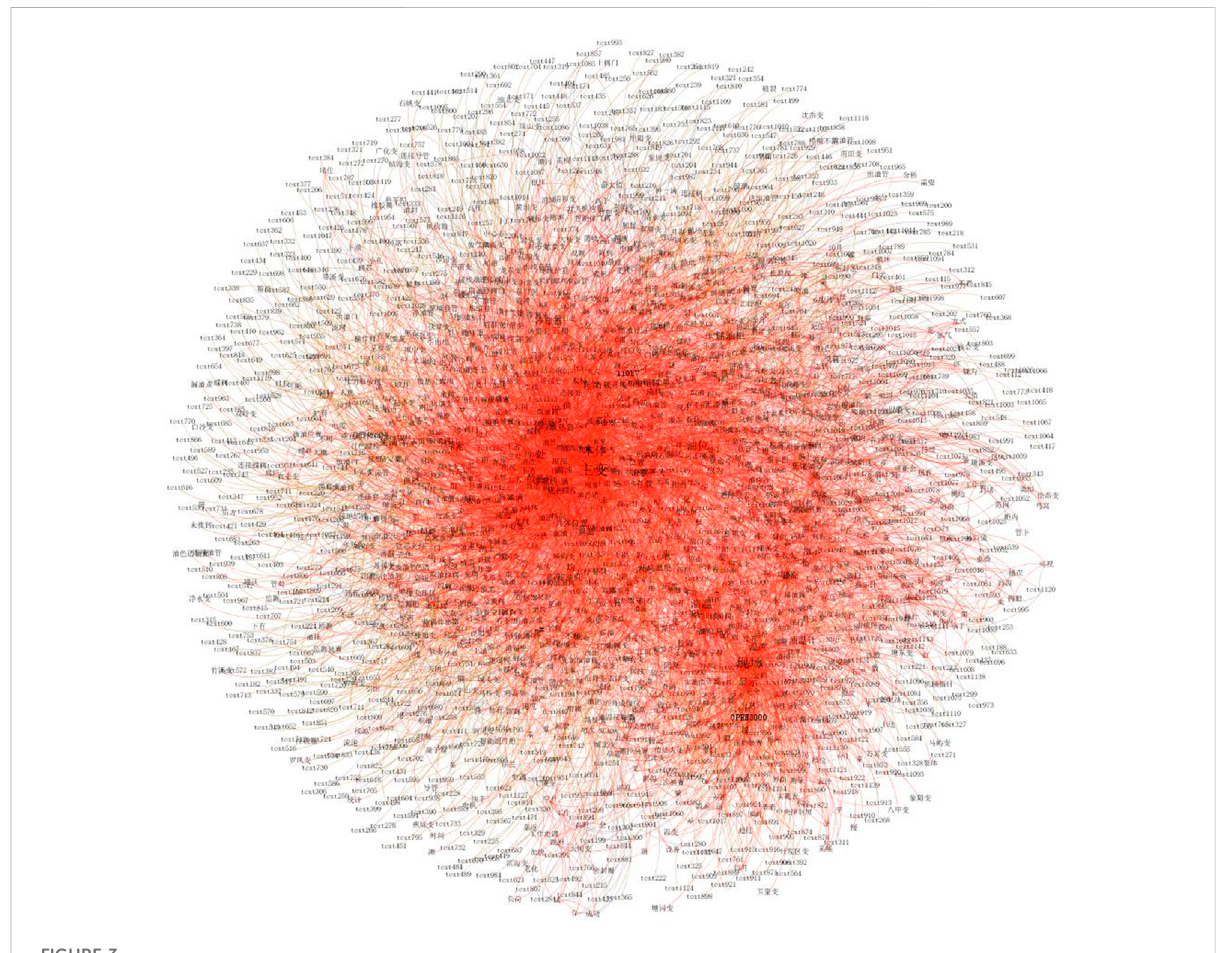
FIGURE 3 Large-scale defect text network